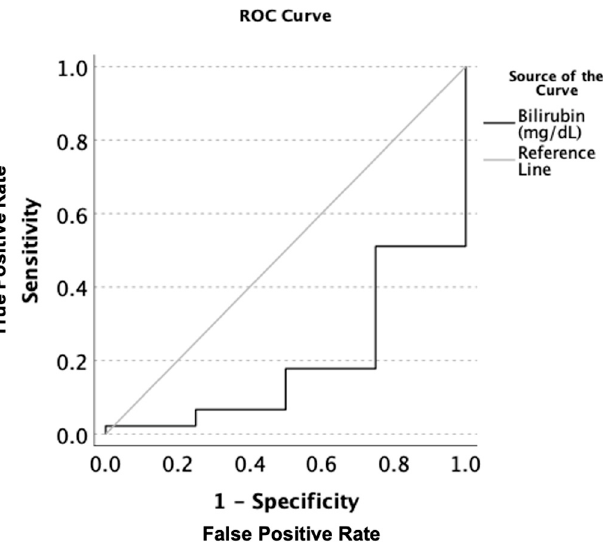
Figure 1. AUROC analysis of the serum total bilirubin levels (mg/dL) in all patients with alcoholic hepatitis when comparing magnesium deficient to magnesium non-deficient patients. Sensitivity describes the ability of this test to correctly identify patients with hypomagnesemia using total serum bilirubin. 1-Specificity is the ability of this test to correctly identify participants in this study without hypomagnesemia in the context of the total serum bilirubin.